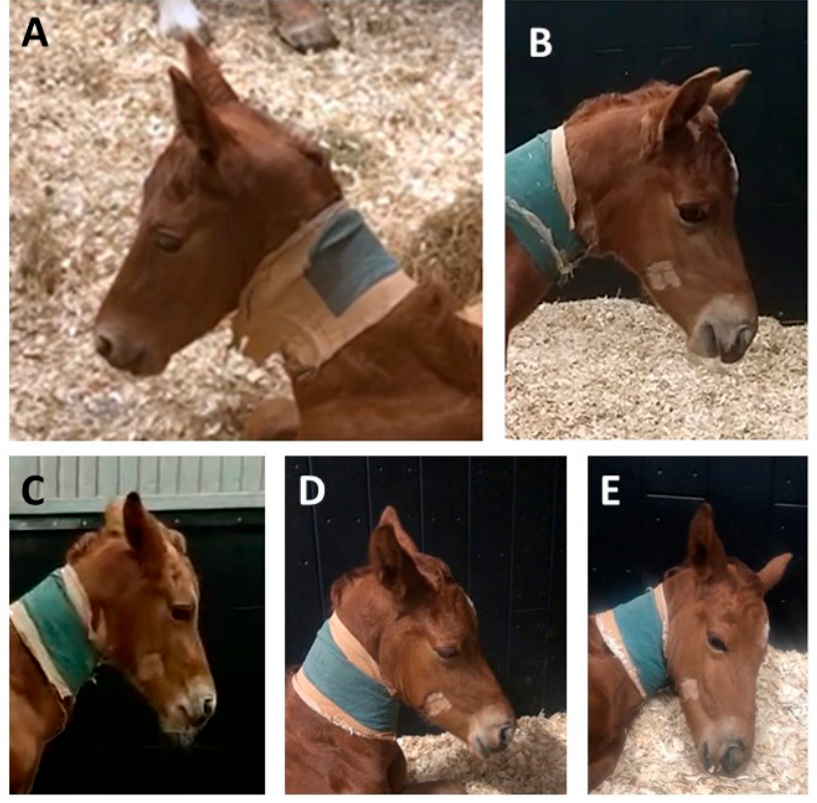
Figure 4. ( A – E ) Examples of 9 days old Warmblood foal after surgery for proximal phalanx fracture. Panel A shows a bright and alert foal 2 h after NSAID treatment on day 2 after surgery. The position of the eyelids cannot be completely evaluated due to the direction of the camera. Panel B shows strained corners of the mouth (score 2) and a slightly raised upper eyelid (score 1). Panel C shows backwards-directed ears (score 2) and slightly strained corners of the mouth (score 1). Panel D shows the backwards position of the ears (score 2) and tightened eyelids (score 2), while the corners of the mouth are relaxed (score 0). Panel E shows the foal during rest, with slightly tightened eyelids (score 1) and the ears directed to the sides (score 1). Panels B–E were all acquired during the first day after